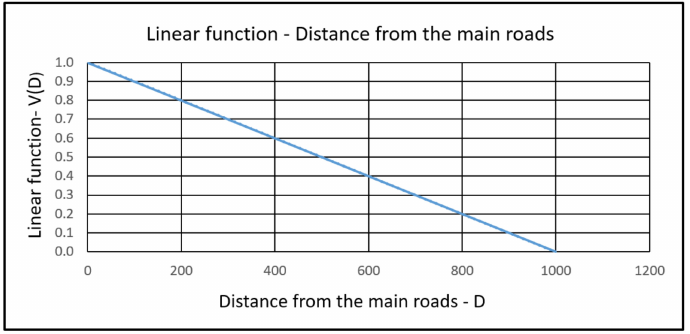
Figure 8. Graph of the linear function of the distance from the main roads. Standardized values of distance from main roads are hereinafter referred to as D ’ j . Slope